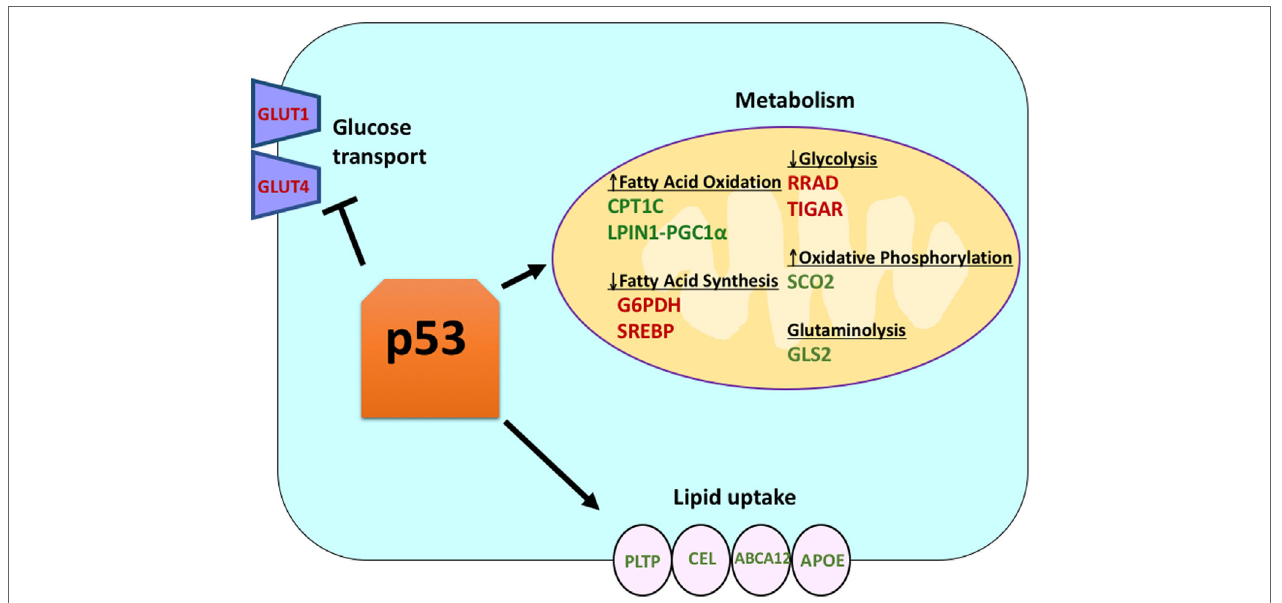
FigURe 1 | The role of wild-type (WT) p53 in metabolism. Genes positively regulated by p53 are shown in green, and genes negatively regulated by p53 are shown in red. p53 inhibits glucose transport, glycolysis, and fatty acid synthesis while it promotes lipid uptake, fatty acid oxidation, oxidative phosphorylation, and